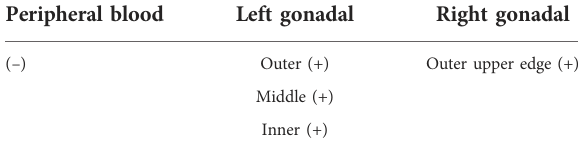
TABLE 2 SRY gene PCR